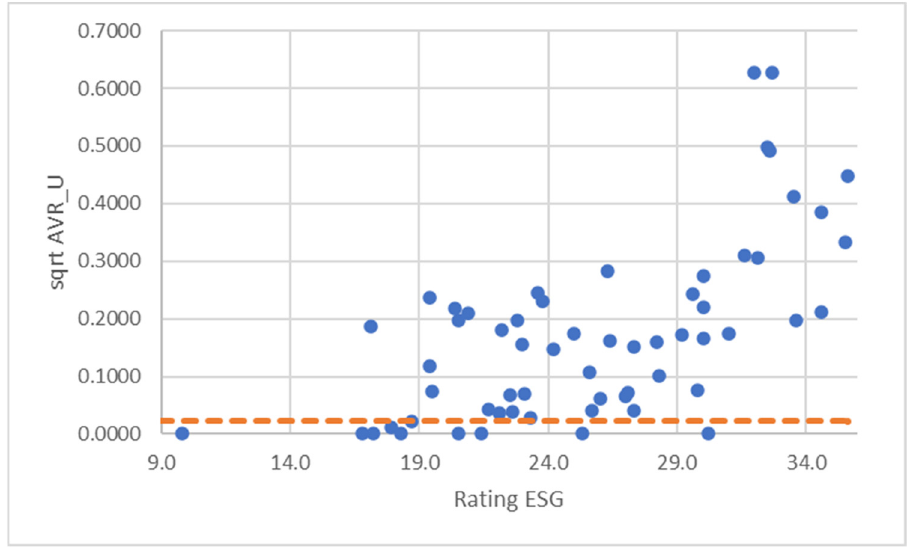
Figure 3. Relation between ESG ratings ( X -axis) and the square root of AVR_U ( Y -axis). The horizontal line represents the cut-off value translated into dummy variable AVR_U_cut-off.